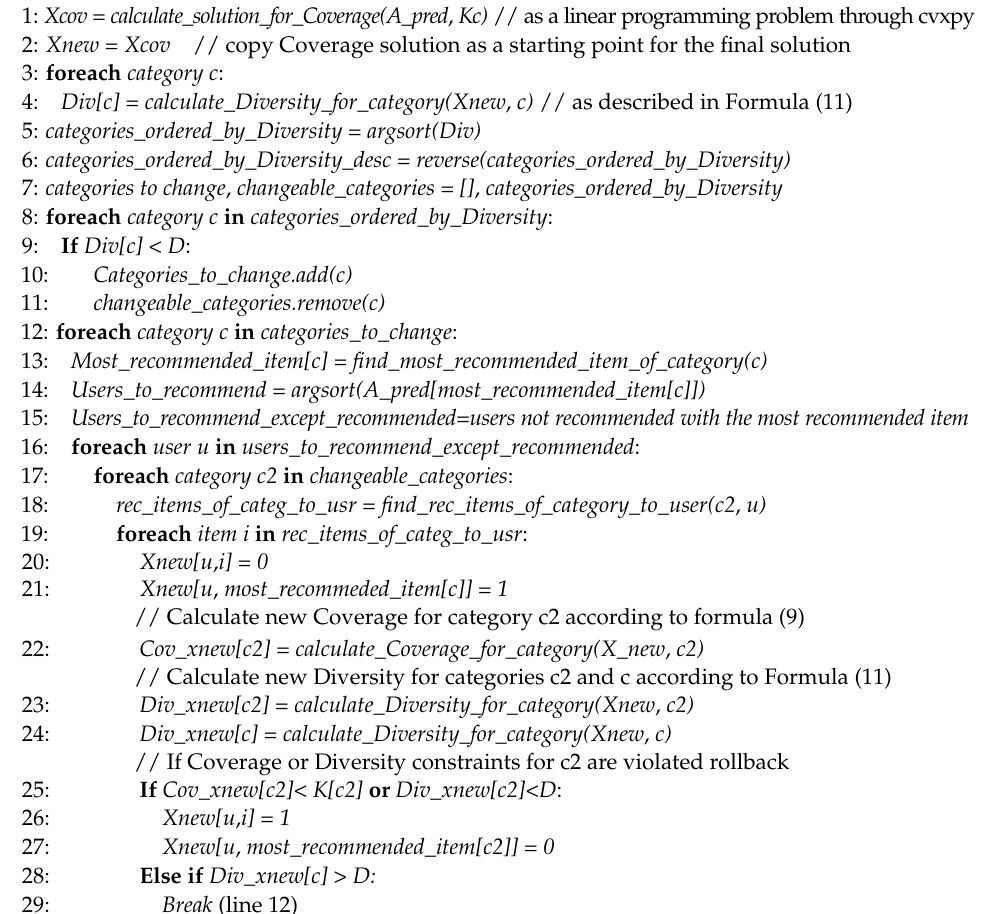
Algorithm 1 Heuristic algorithm for addressing diversity